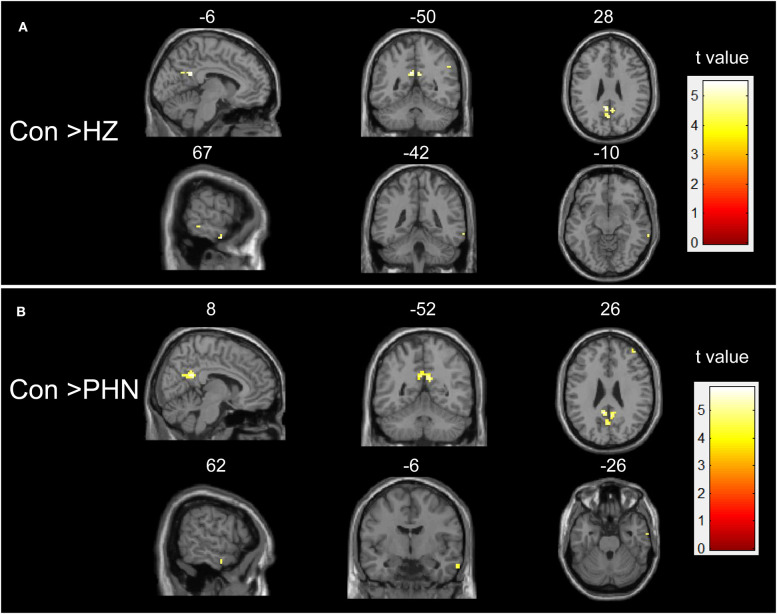
Intergroup difference in amplitude of low-frequency fluctuation (ALFF). Both comparisons of HZ vs. healthy controls (HC) (A) and PHN vs. HC (B) groups showed a significant decrease in ALFF in some brain areas. Threshold of the whole brain: p < 0.05, false discovery rate corrected, cluster size > 5. HZ, herpes zoster; PHN, postherpetic neuralgia; Con, normal controls.